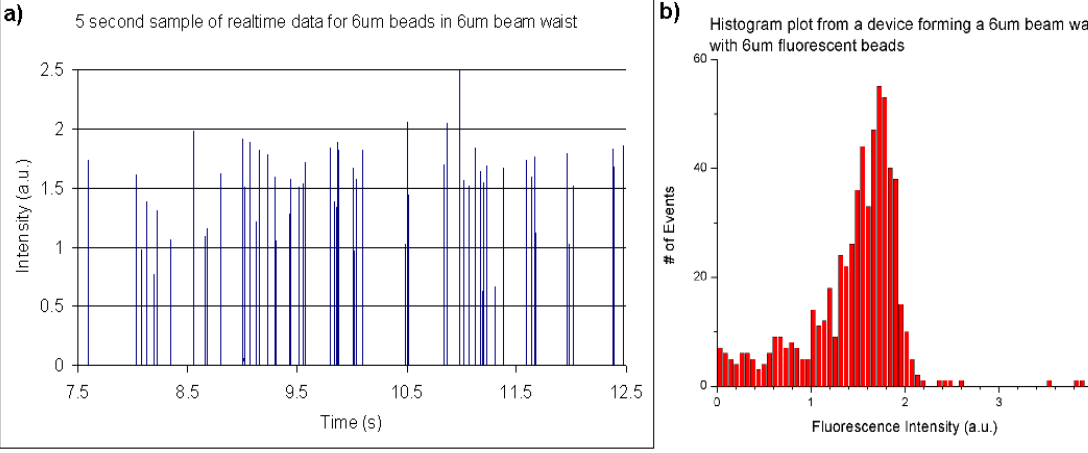
Figure 8. Results of a fluorescence test from 6.0 μ m beads in a device that forms a 6 μ m beam waist. The burst peaks in the real-time data ( a ) have a slightly larger variation and show a greater spread around a central mean in the histogram ( b ). The CV of this particular run was